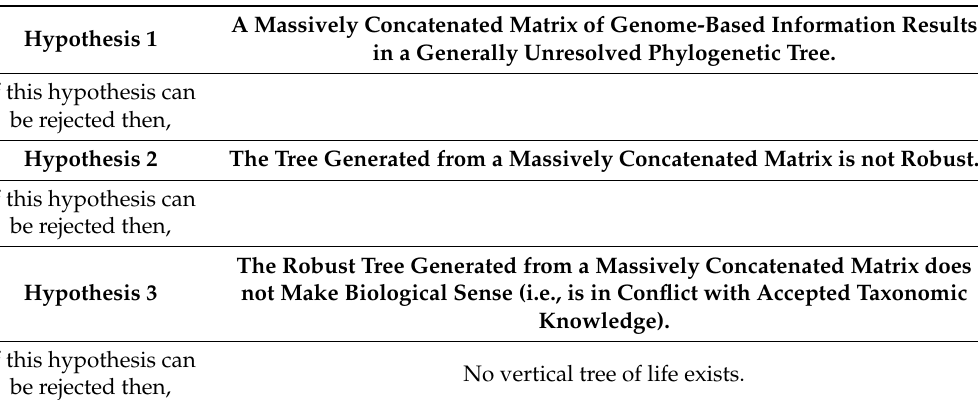
Table 1. Three hypotheses that can be tested to examine the validity of a vertical tree of